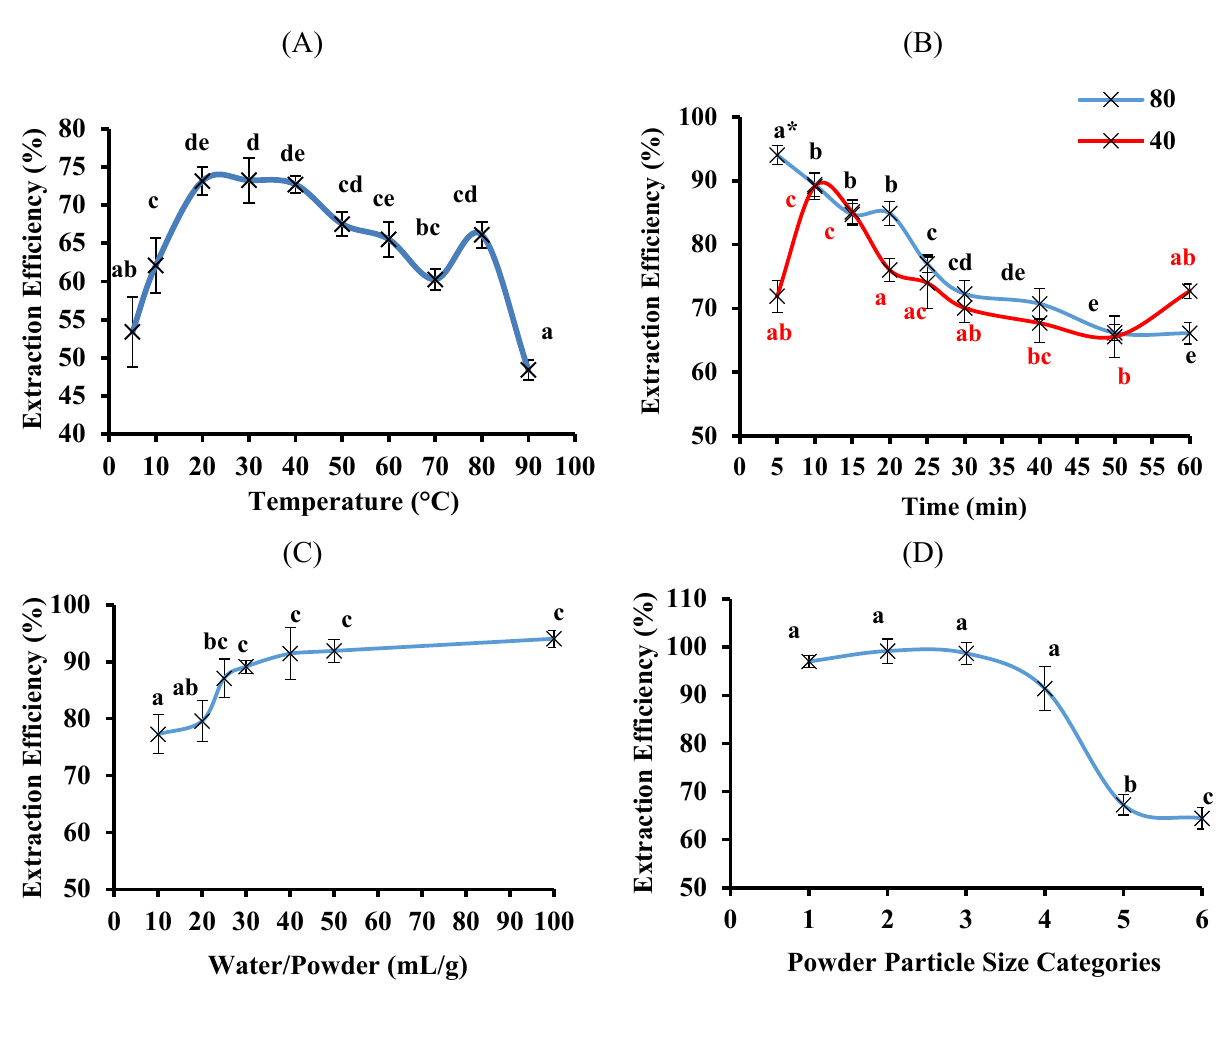
Figure 4. The extraction efficiency for phenolic compounds from bitter melon using water. The aqueous extraction was optimised using one-variable-at-a-time method and each variable was tested in sequential order: ( A ) temperature; ( B ) time; ( C ) water-to-powder ratio; ( D ) powder particle size and ( E ) number of times the same sample is extracted. The powder particle size categories were: (1) <0.25, (2) 0.25–0.05, (3) 0.5–1.0, (4) 1.0–2.0, (5) 2.0–2.8 and (6) >2.8 mm. The extraction efficiency was relative to the 80% ethanol extract and data are means ± standard deviations ( n = 3) and those not sharing a letter are significantly different ( p < 0.05) from each other. * This value is also significantly different ( p < 0.05) from the values obtained at 40